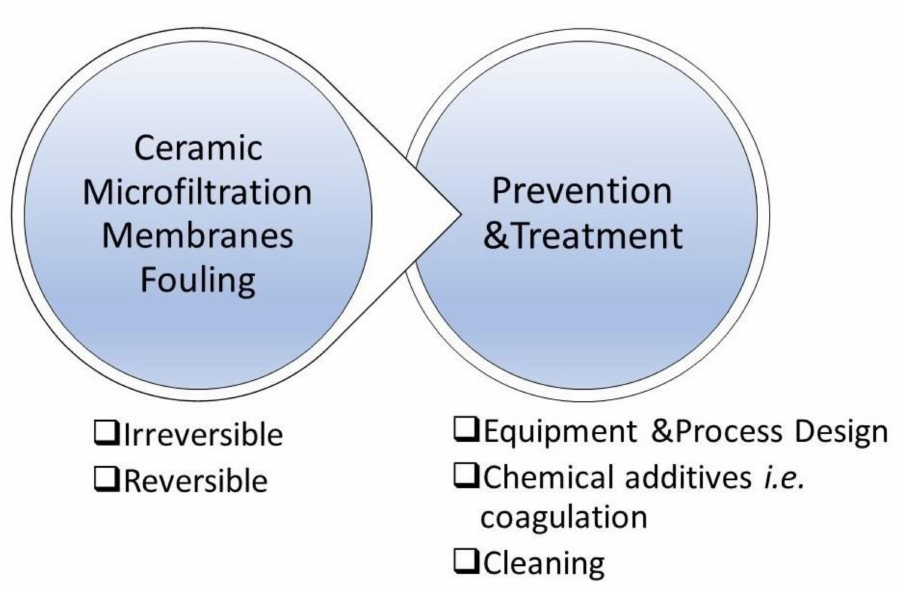
Figure 6. Membrane fouling prevention and treatment